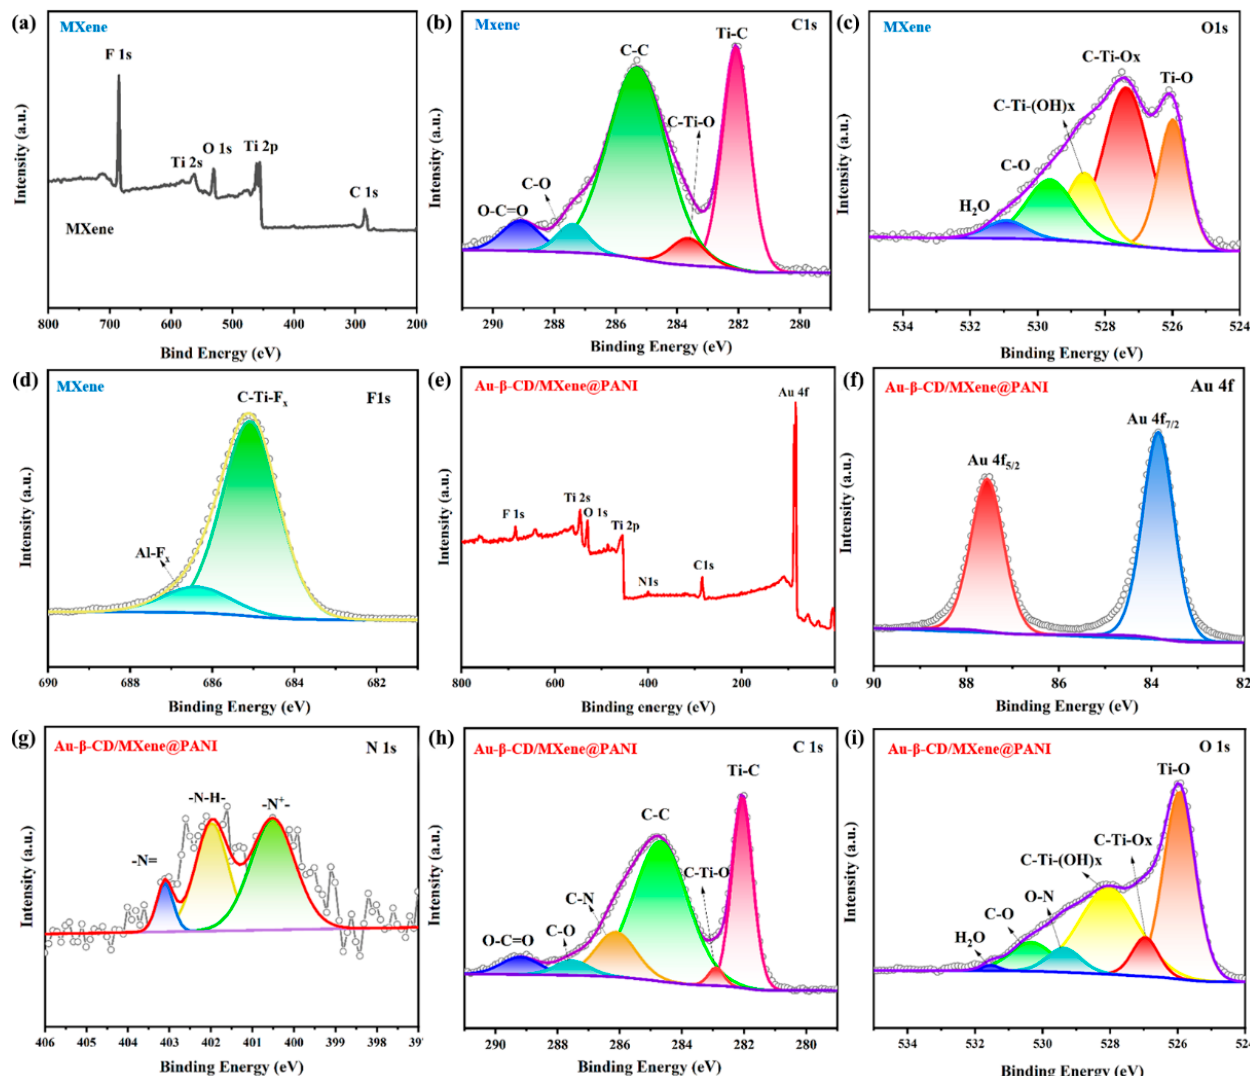
Figure 2. XPS spectra of f-MXene: ( a ) survey, ( b ) C 1s, ( c ) O 1s, and ( d ) F 1s. XPS spectra of Au- β -CD/MXene@PANI: ( e ) survey, ( f ) Au 4f, ( g ) N 1s, ( h ) C 1s, and ( i ) O 1s.